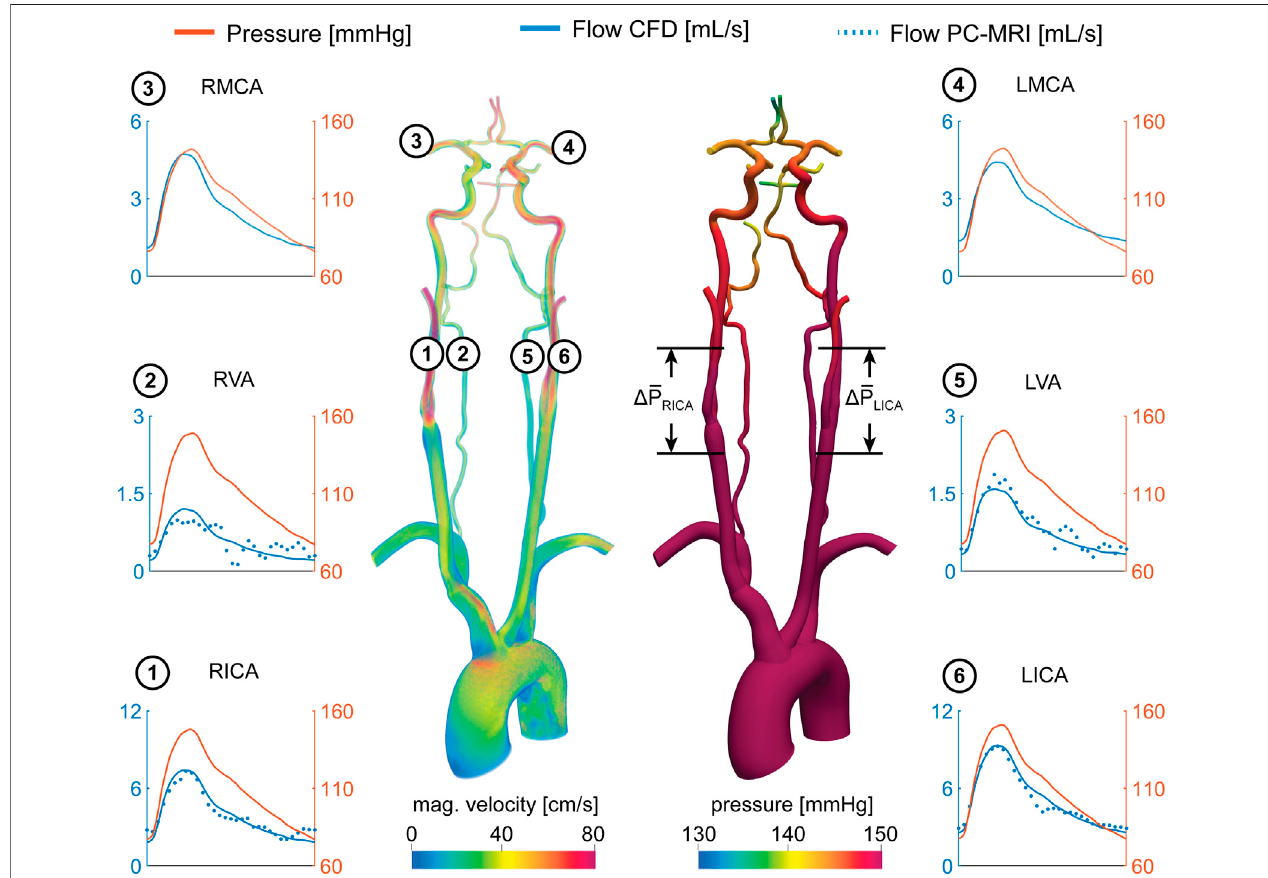
FIGURE 8 | Velocity and pressure fi elds at peak systole for patient 2. Flow and pressure waveforms are evaluated in the internal carotid (ICA), vertebral (VA), and middle cerebral arteries (MCA). The fl ow waveforms in the neck arteries are compared to PC-MRI measurements above the carotid bifurcation (dotted lines). The mean ̅ − P ̅ pressure drop Δ P ̅ (cid:1) P prox dist was calculated over the RICA and LICA